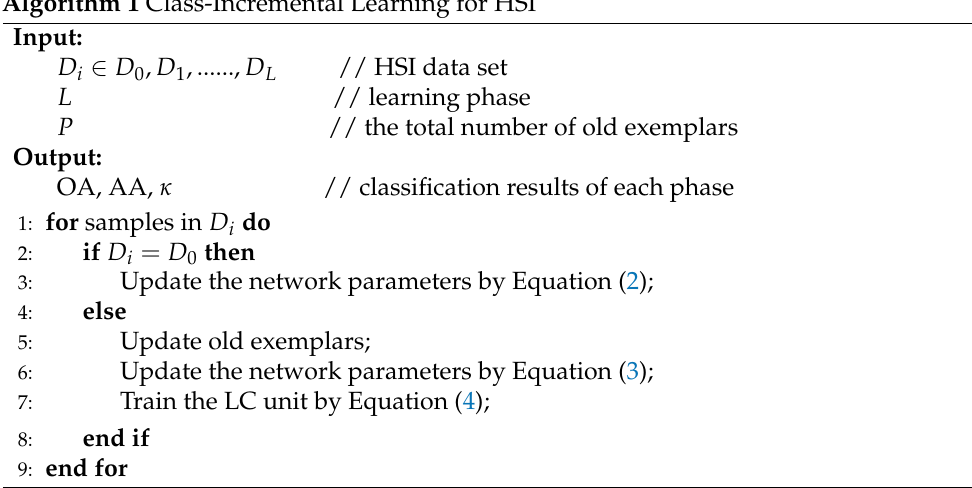
Algorithm 1 Class-Incremental Learning for